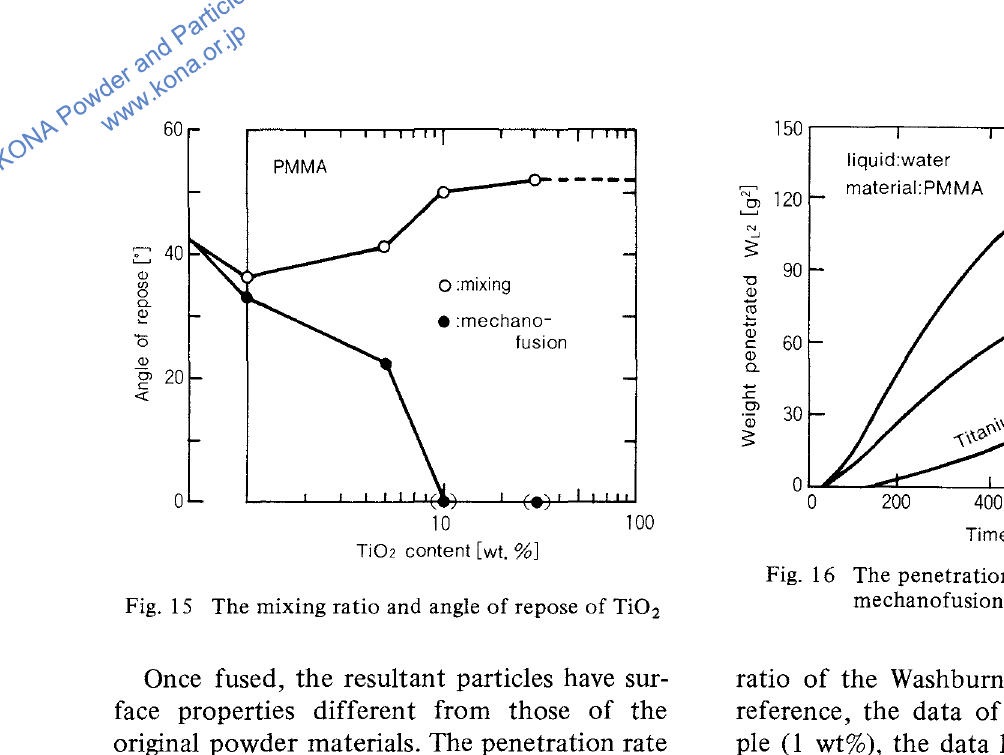
Fig. 15 The mixing ratio and angle of repose of Ti0 2